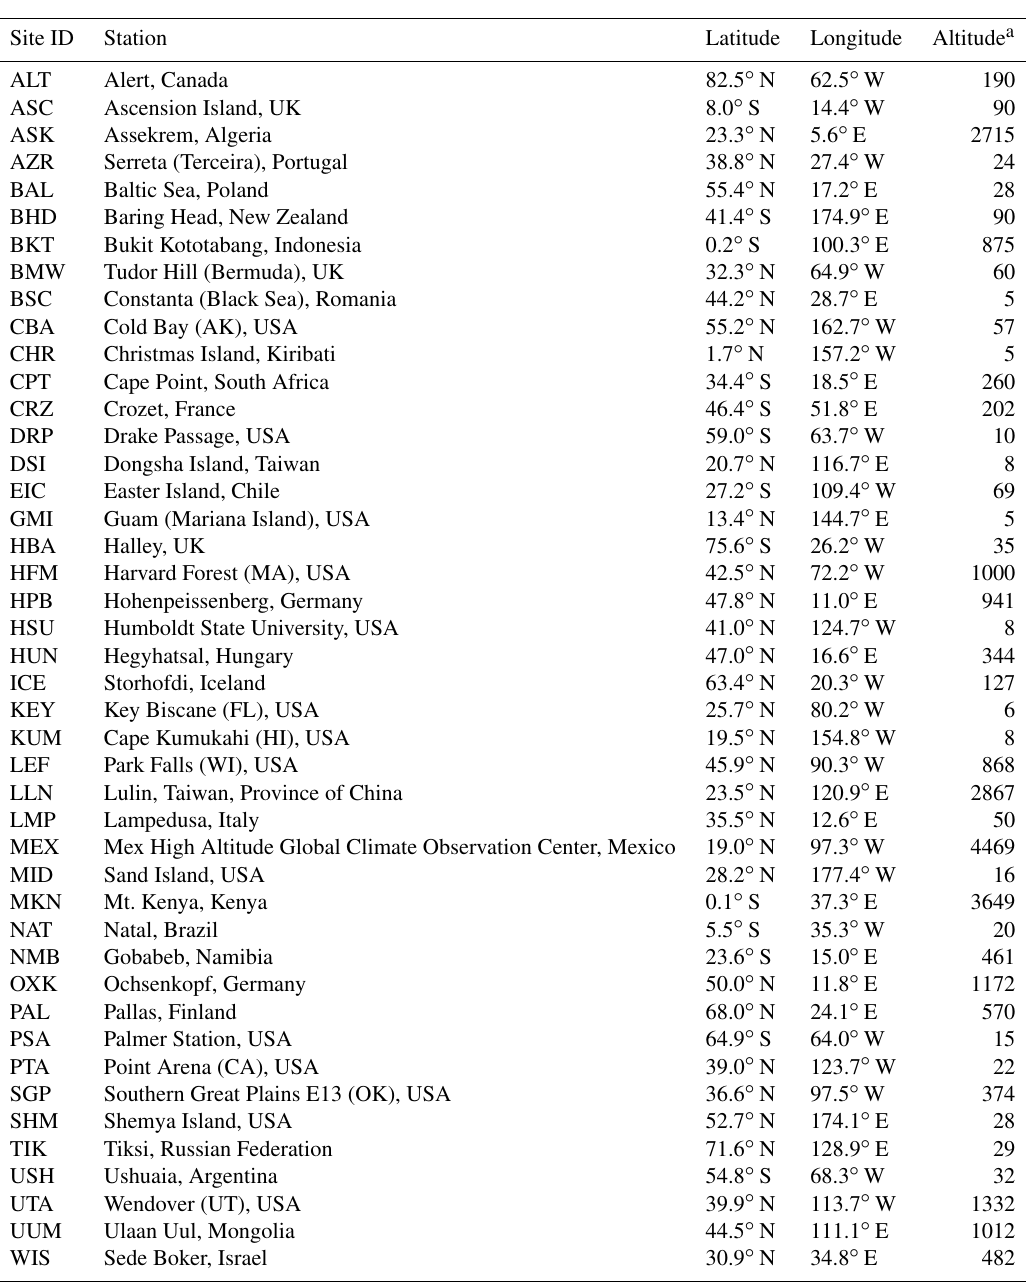
Table A1. Surface flask measurement